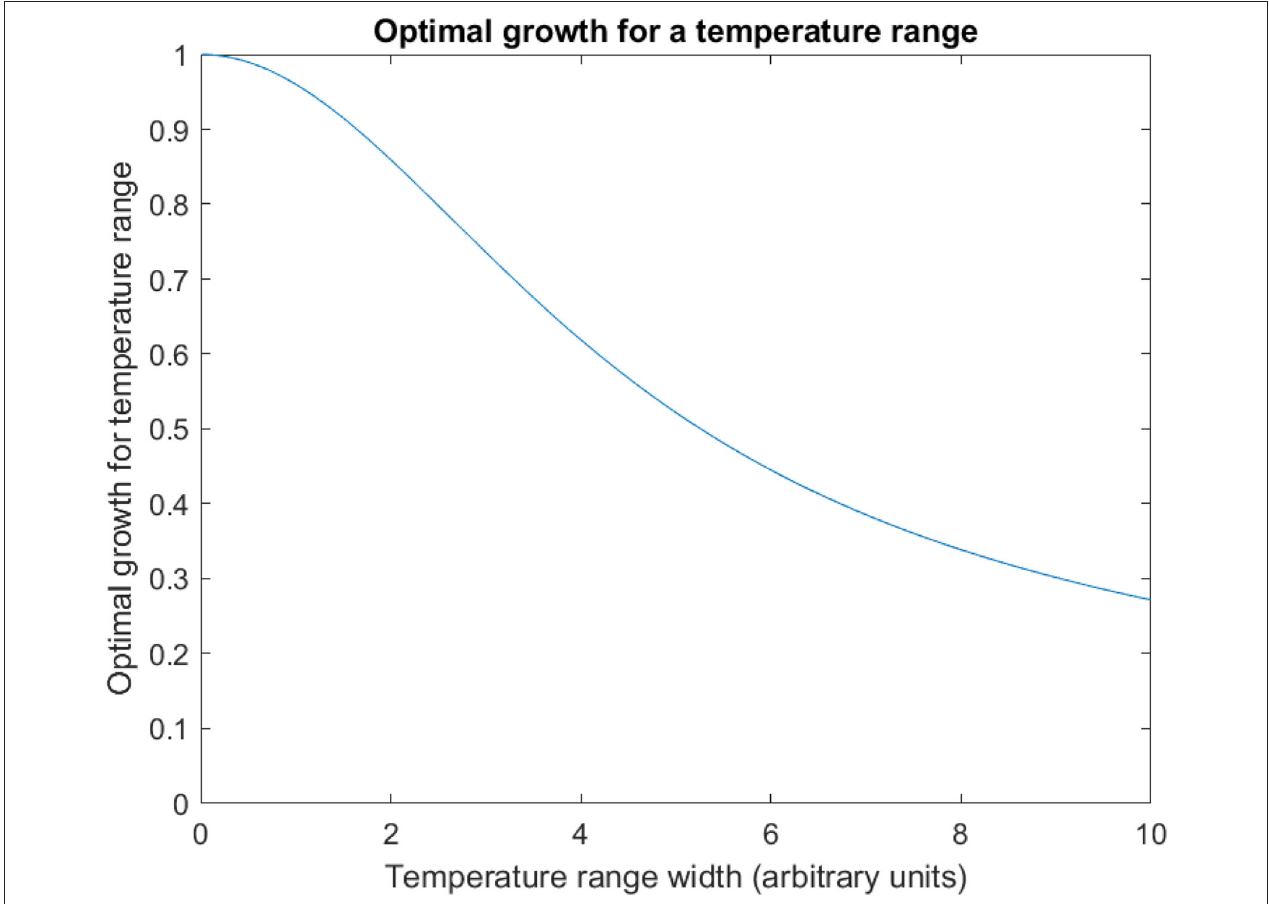
FIGURE 5 | Optimal growth for a temperature range. The optimum solution for mean pathogen growth rate for uniform temperature variation is plotted against the k width of this range ( k in the text), for 0 10. This is normalised to optimal growth at a single temperature (thus is 1 when the temperature range is zero—i.e., a ≤ ≤ single point). As the temperature range increases, the optimal growth across this temperature range falls sigmoidally compared to growth at a single